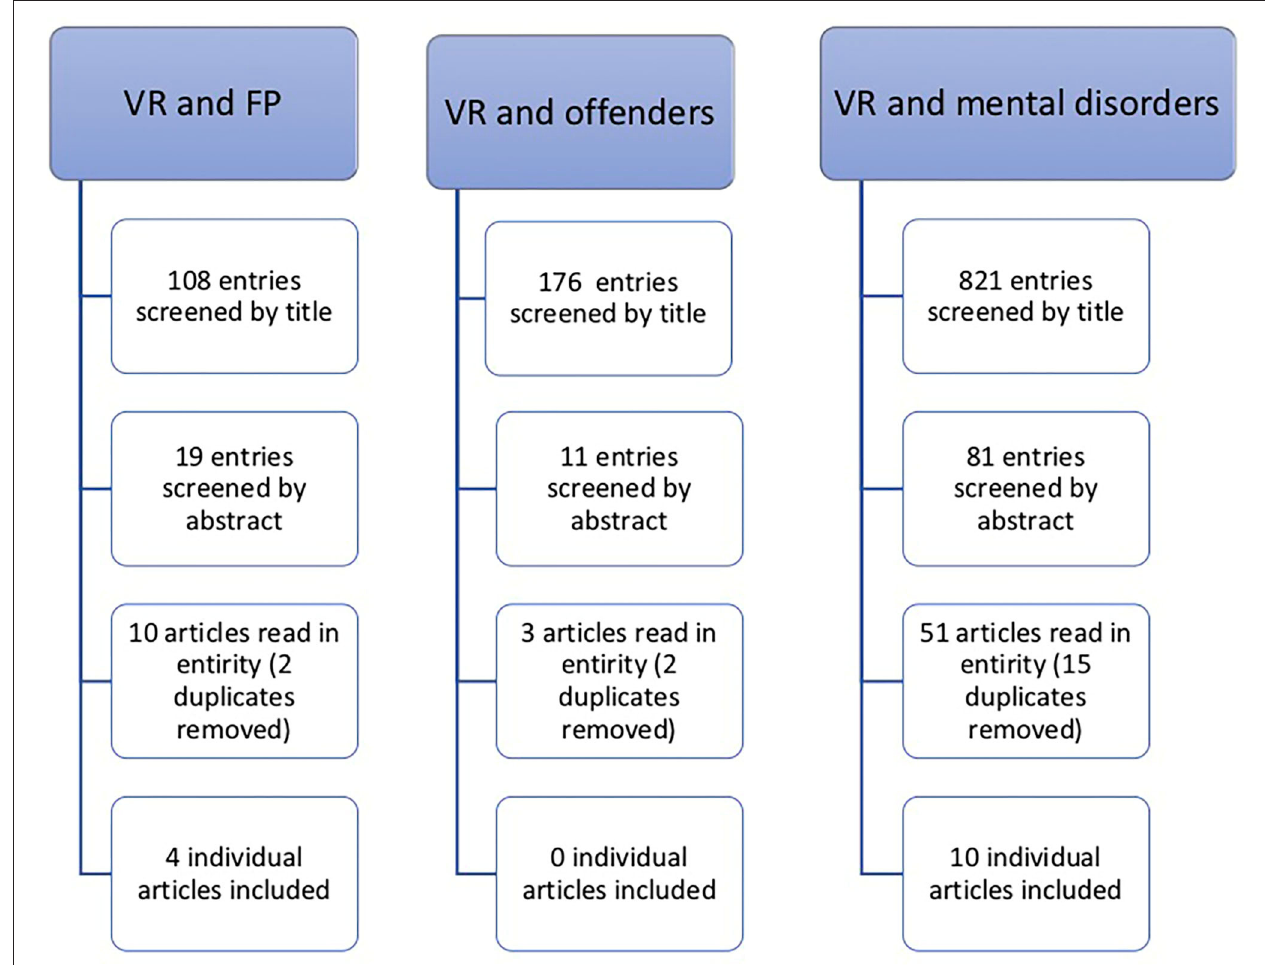
FIGURE 1 | Aggregated results of the searches performed in PubMed, PsycINFO, and Web of Science